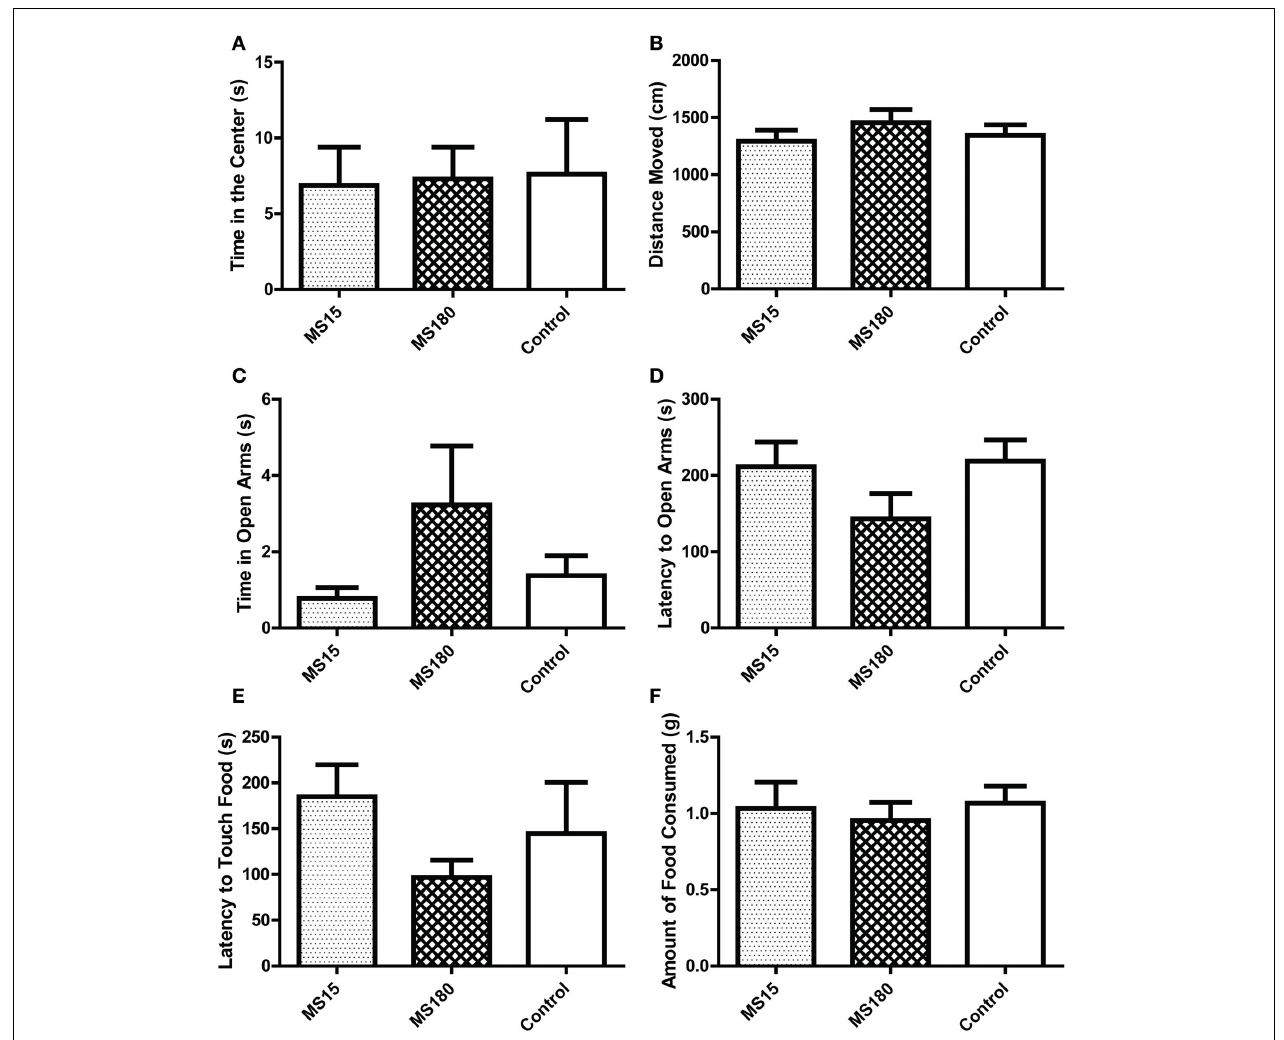
FIGURE 7 | Early-life experience does not alter WKY anxiety-like behavior in the open field test, elevated plus maze, and novelty-suppressed feeding test. We evaluated anxiety-like behavior in adult male WKY control rats as well as WKYs that were separated from their dams for 15min (MS15) or 180min (MS180) per day during the first 2 weeks of life. All three groups spent similar time in the center of the open field (A)